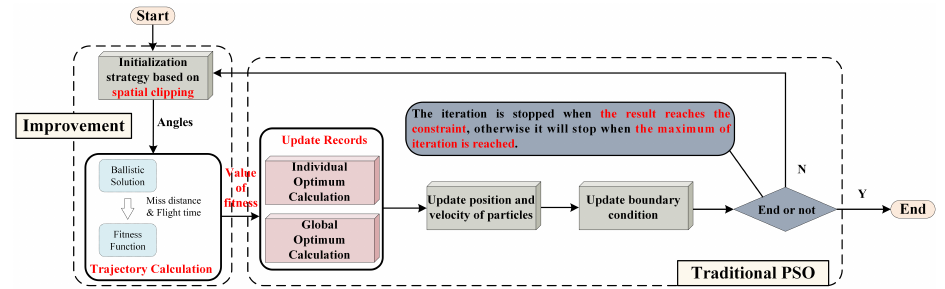
Figure 5. The follow diagram of the IPSO